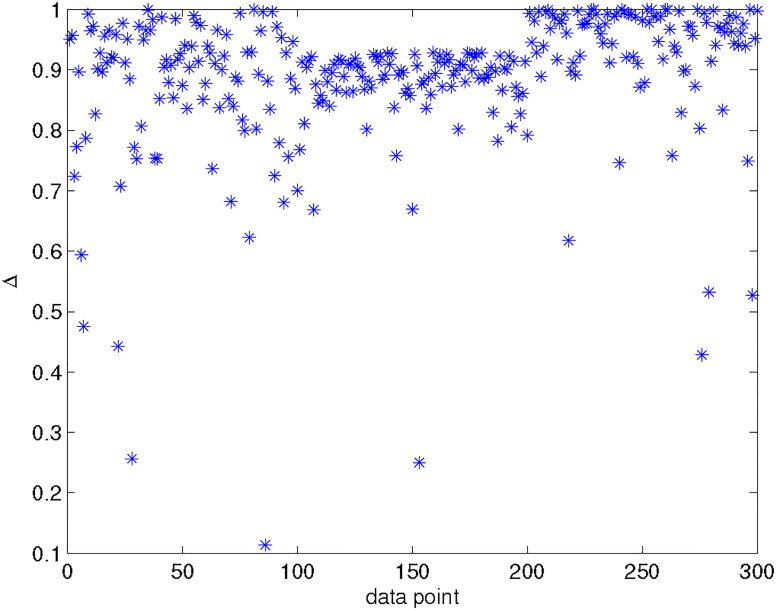
The gap in the posterior distribution: The difference between the highest and second highest peaks.